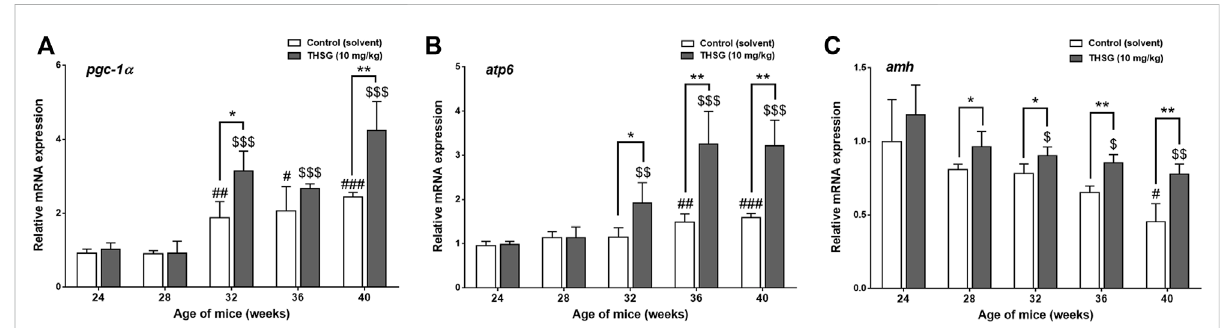
FIGURE 7 THSG affects gene expression of mitochondrial biogenesis in aged mice groups. Mice fed with THSG or untreated controls were sacri fi ced at theendof24,28,32,36,and40 weeksofage.OvarieswereharvestedandtotalRNAwasextracted.qPCRwasconductedfor pgc1 α (A) , atp6 (B) ,and amh (C) . The number of independent studies ( n ) = 4. Results were expressed as the mean ± SD; * p < 0.05, ** p < 0.01, *** p < 0.001, compared with eachage-matchedcontrolgroup;# p < 0.05,## p < 0.01,### p < 0.001,comparedwiththecontrolgroupof24-week-oldmice;$ p < 0.05,$$ p < 0.01, $$$ p < 0.001, compared with the THSG-treated group of 24-week-old